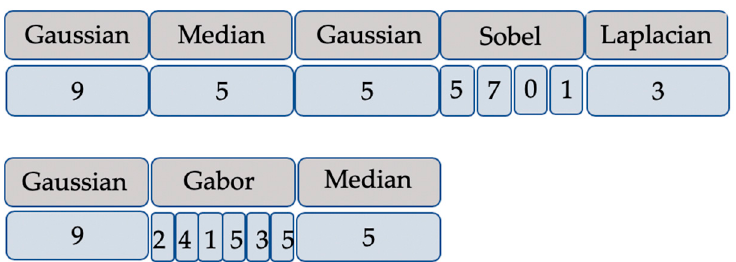
Figure 2. Two examples of learned features from evolutionary learning. The first example shows a feature that has five transforms. The second one has three transforms. The values below the transforms are their parameters.